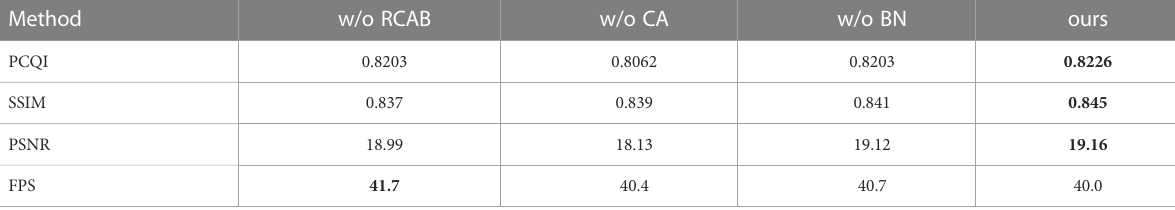
TABLE 9 Comparison of RCAB and BN using the UIEB dataset. Method w/o RCAB w/o CA w/o BN.